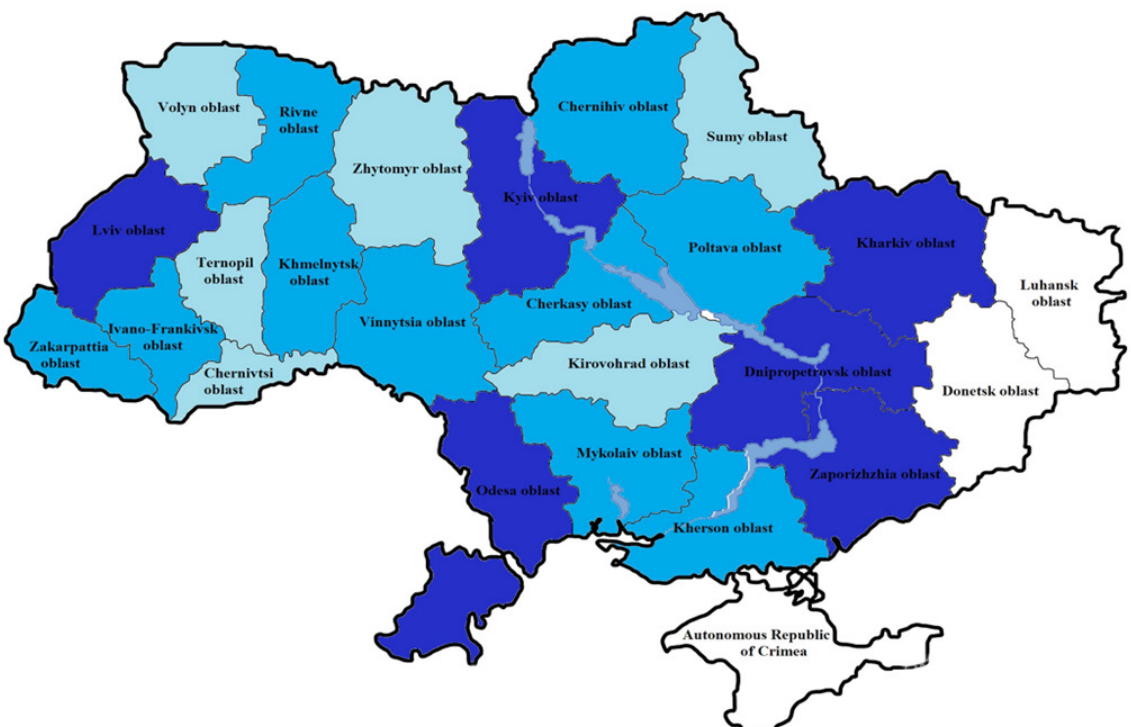
Figure I1. Grouping of regions* according to the integrated index of investment potential of tourist